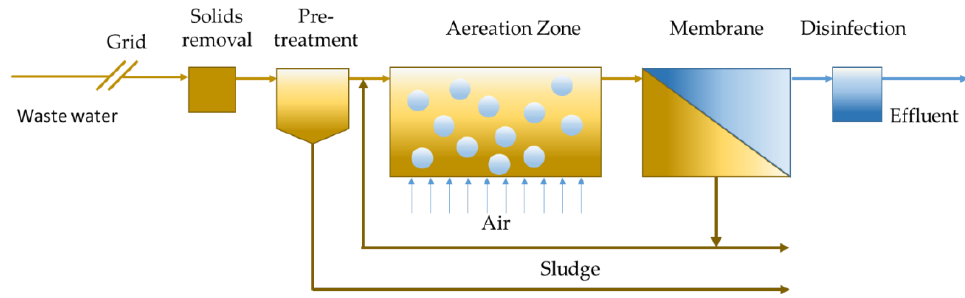
Figure 5. Schematic representation of membrane bioreactor (MBR) process.